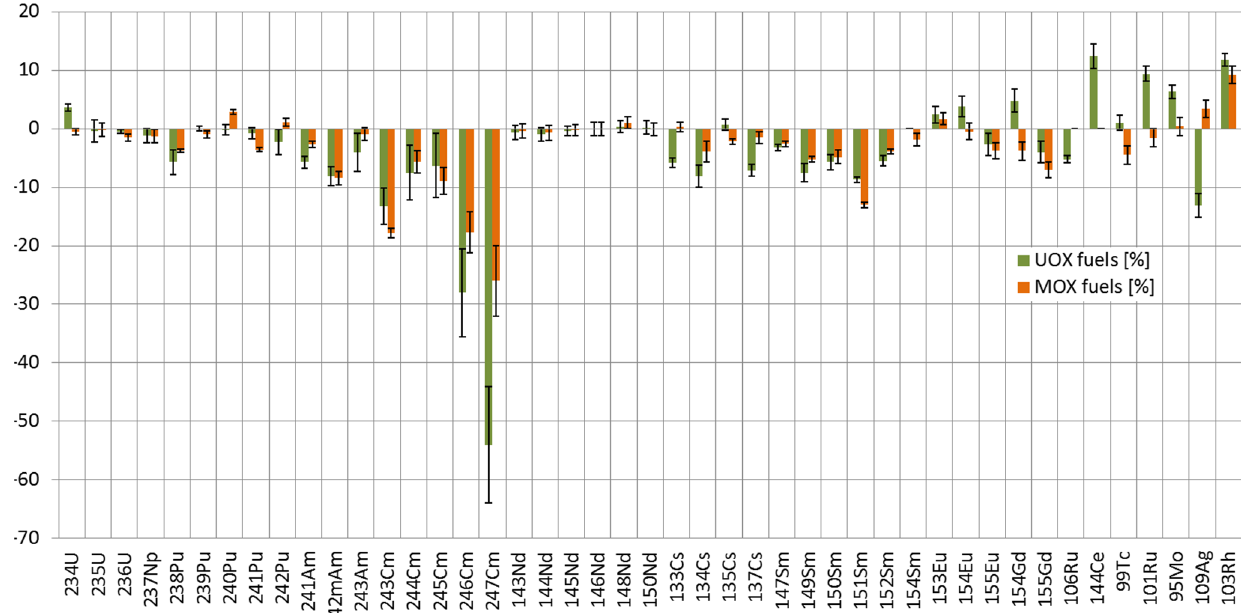
Fig. 2. Average calculated-to-experimental values ( 〈 C/E i -1) obtained for UOX and MOX fuels with the DARWIN2.3 package at 40 GWd/t using the JEFF-3.1.1